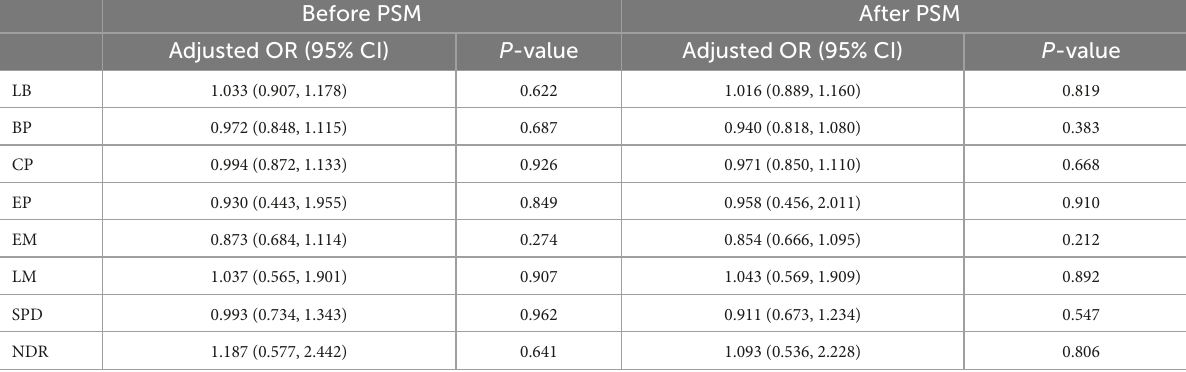
TABLE 3 Multivariate logistic regression analysis of pregnancy outcomes for immediate FET and delayed